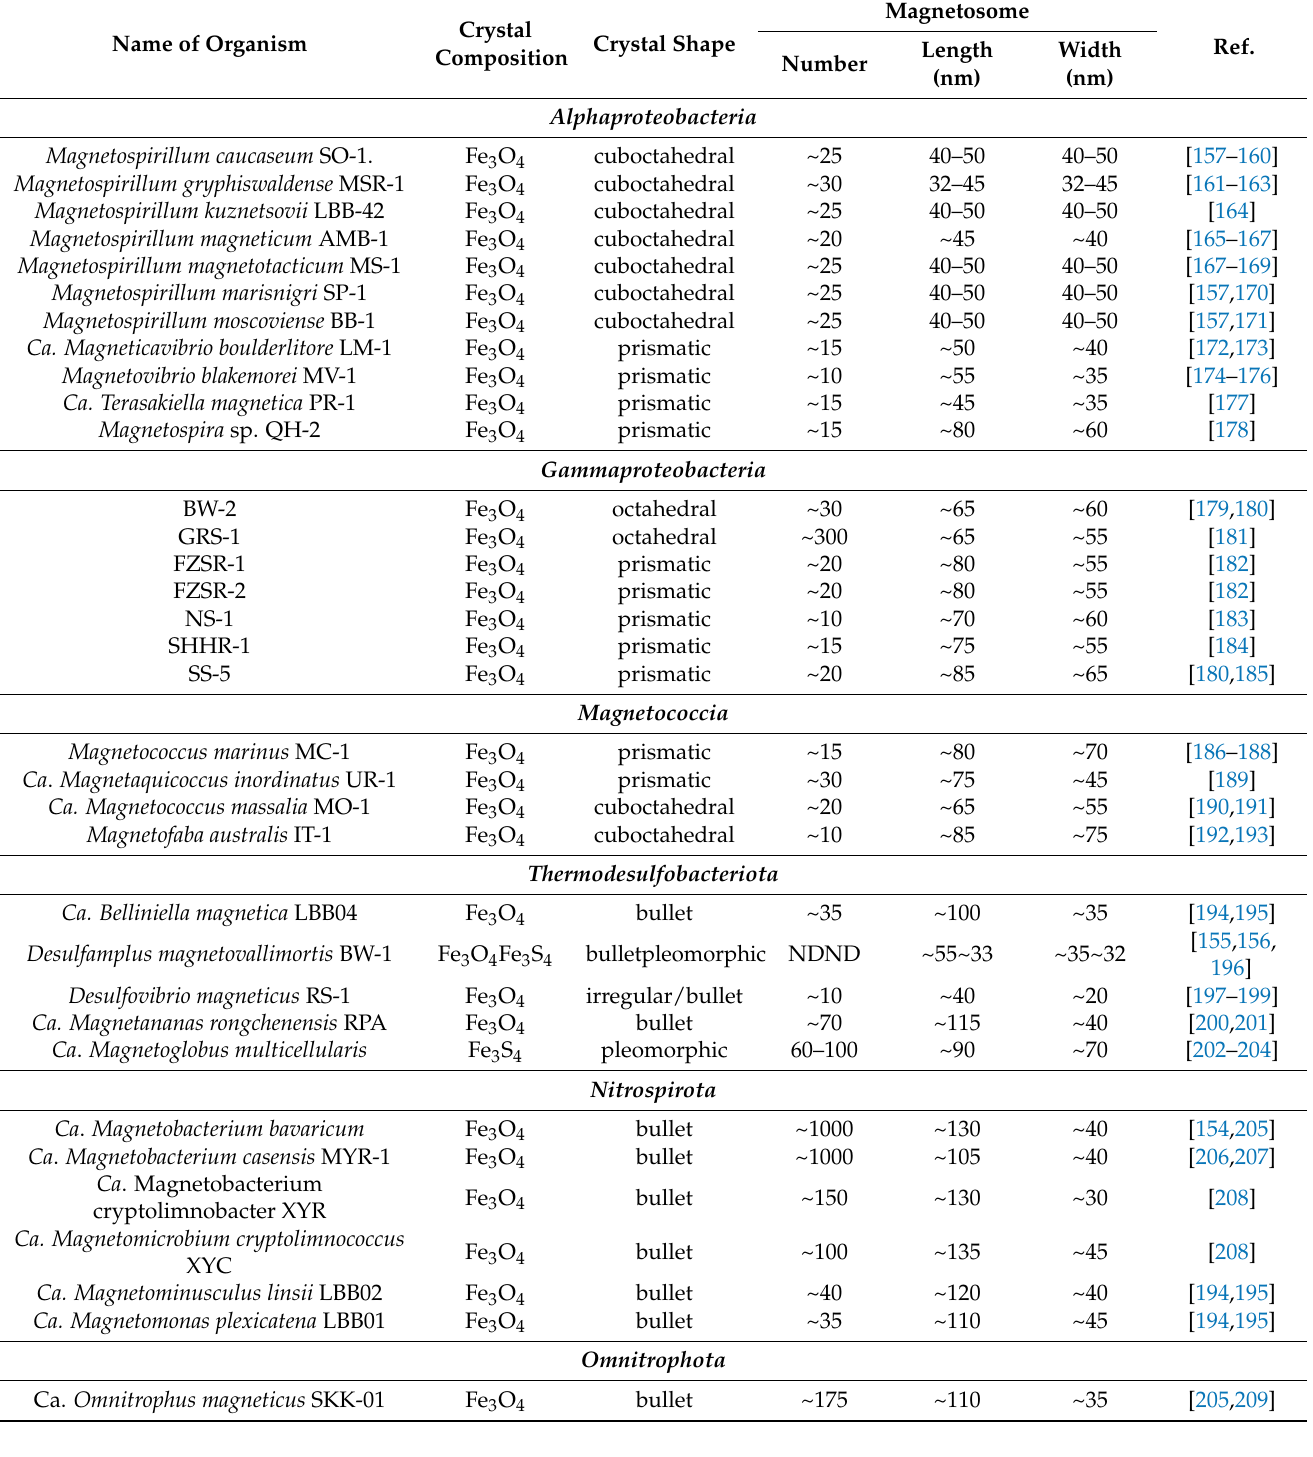
Table 3. Characteristics of magnetosomes from phylogenetically and morphologically identified